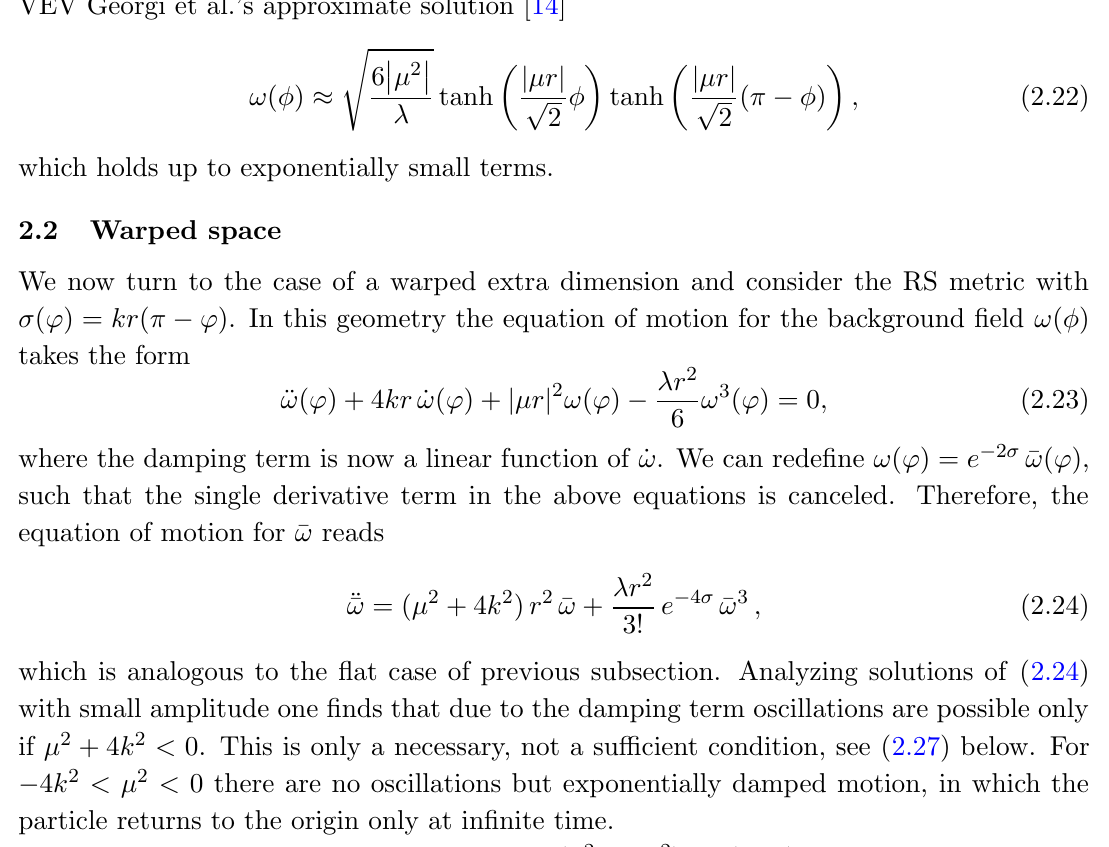
( v ) and the motion of the particle in the (cid:13)at case. V (cid:25) . Using (2.12), we recover for the original (cid:20)